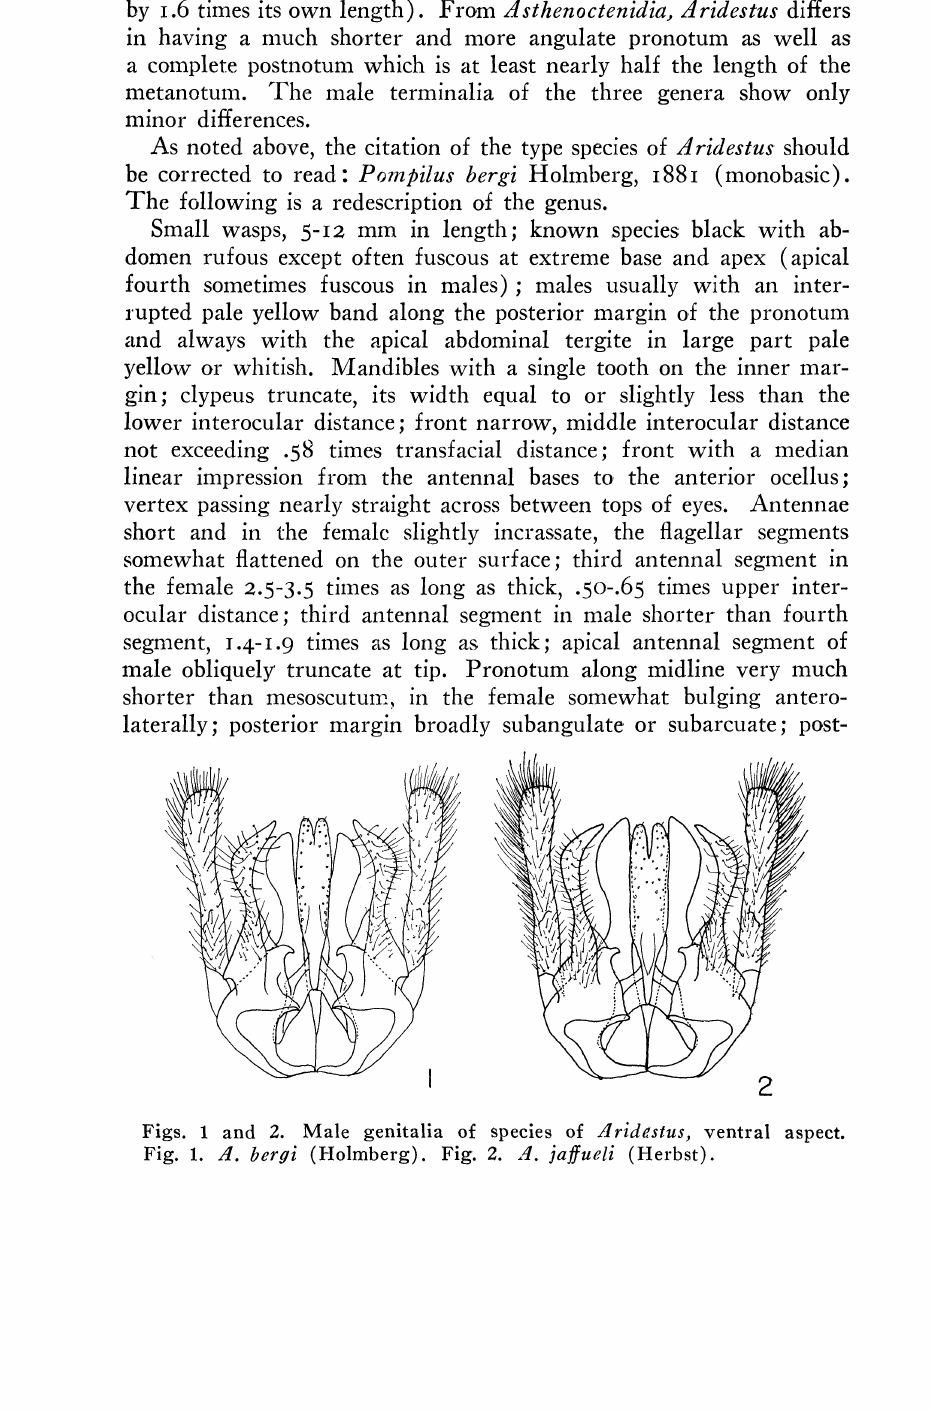
and 2. Male genitalia of species of /lridestus, ventral aspect. Fig. 1. At. berzi (Holmberg). Fig. 2. d. jaffueli